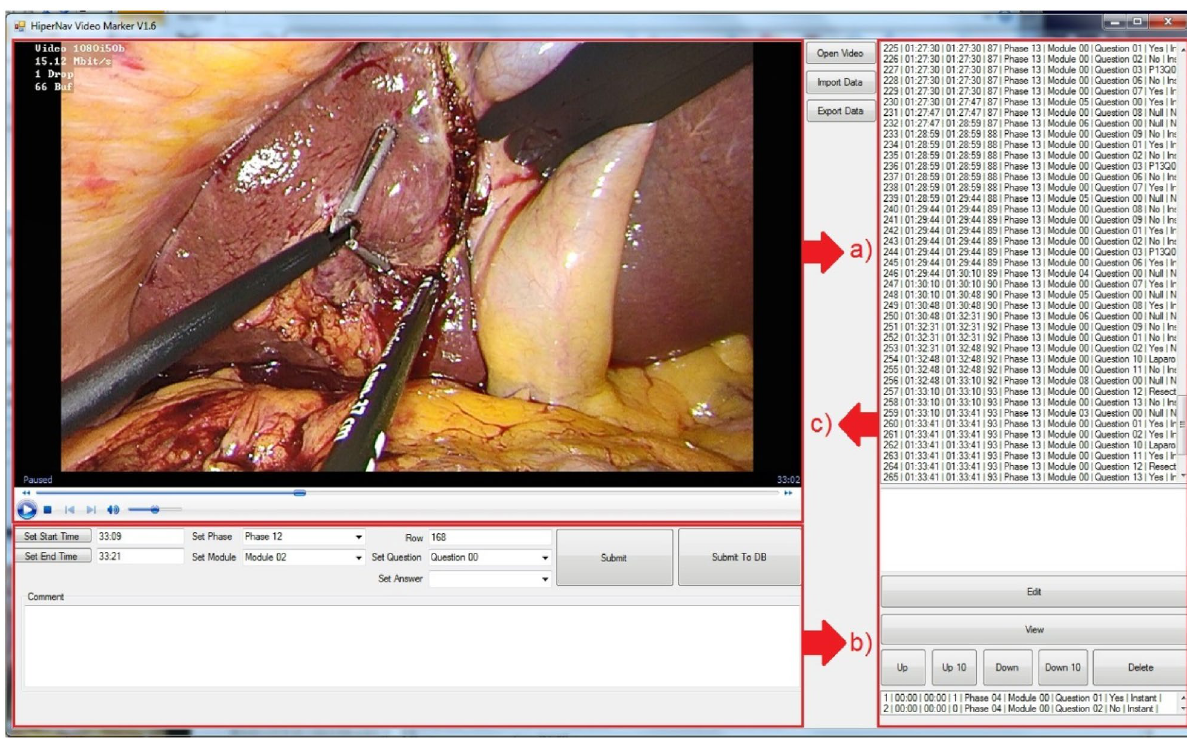
Figure 2. A snapshot of the developed process model data registration software (DOI: https:// doi. org/ 10. 4121/ 20163 926). The software comprises three main sections: ( a ) endoscopic video player, ( b ) data registration panel to register data at the desired granularity level, locally or in the data-base and ( c ) registered data